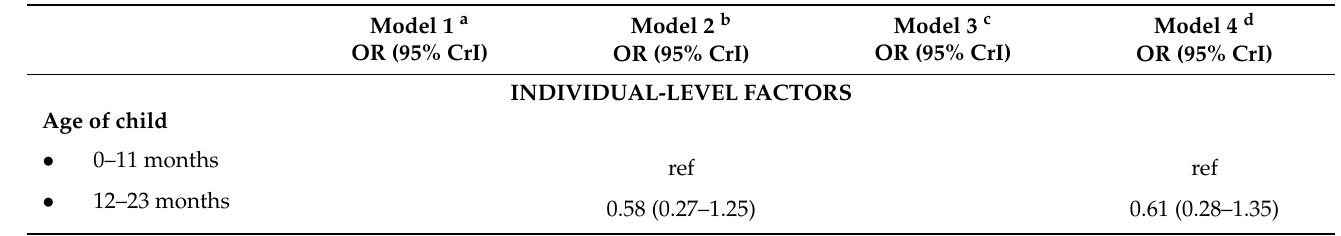
Table 4. Factors associated with missed opportunities for vaccination among children